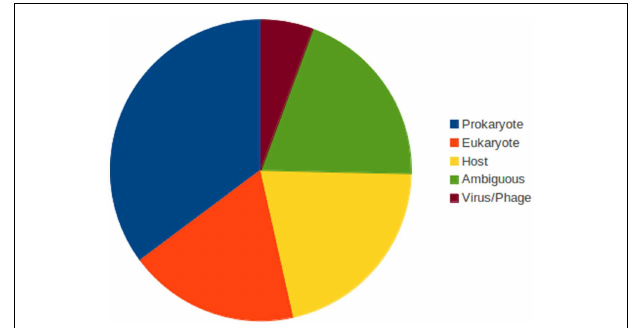
FIGURE 5 | Taxonomic sources of the